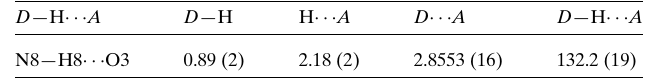
Table 2 Experimental details.